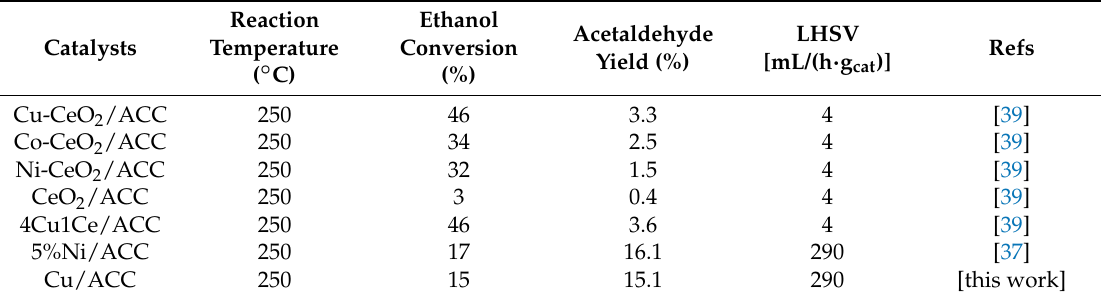
Table 4. Comparison of metal on commercial activated carbon for ethanol dehydrogenation and their catalytic ability.